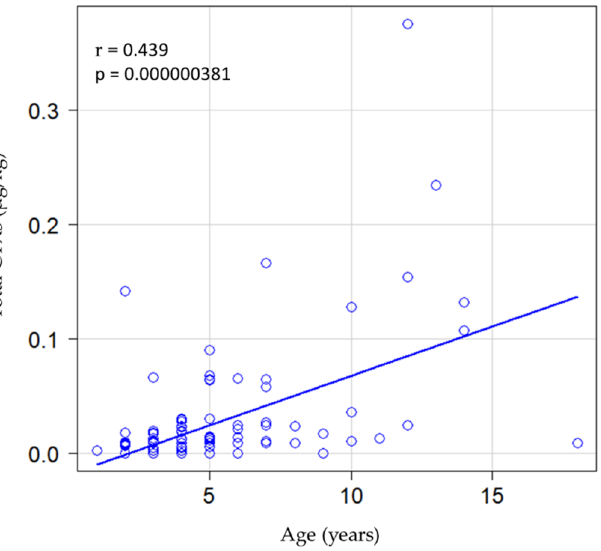
Figure 8. The relationship between age and total CTX levels in the flesh of V. louti specimens collected from Ryukyu Island, Japan.